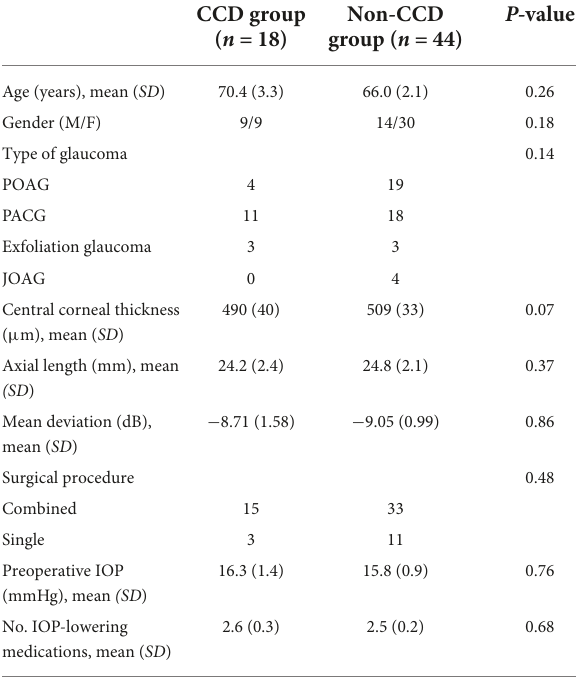
TABLE 2 Clinical characteristics of study patients with or without CCD at postoperative day 1.